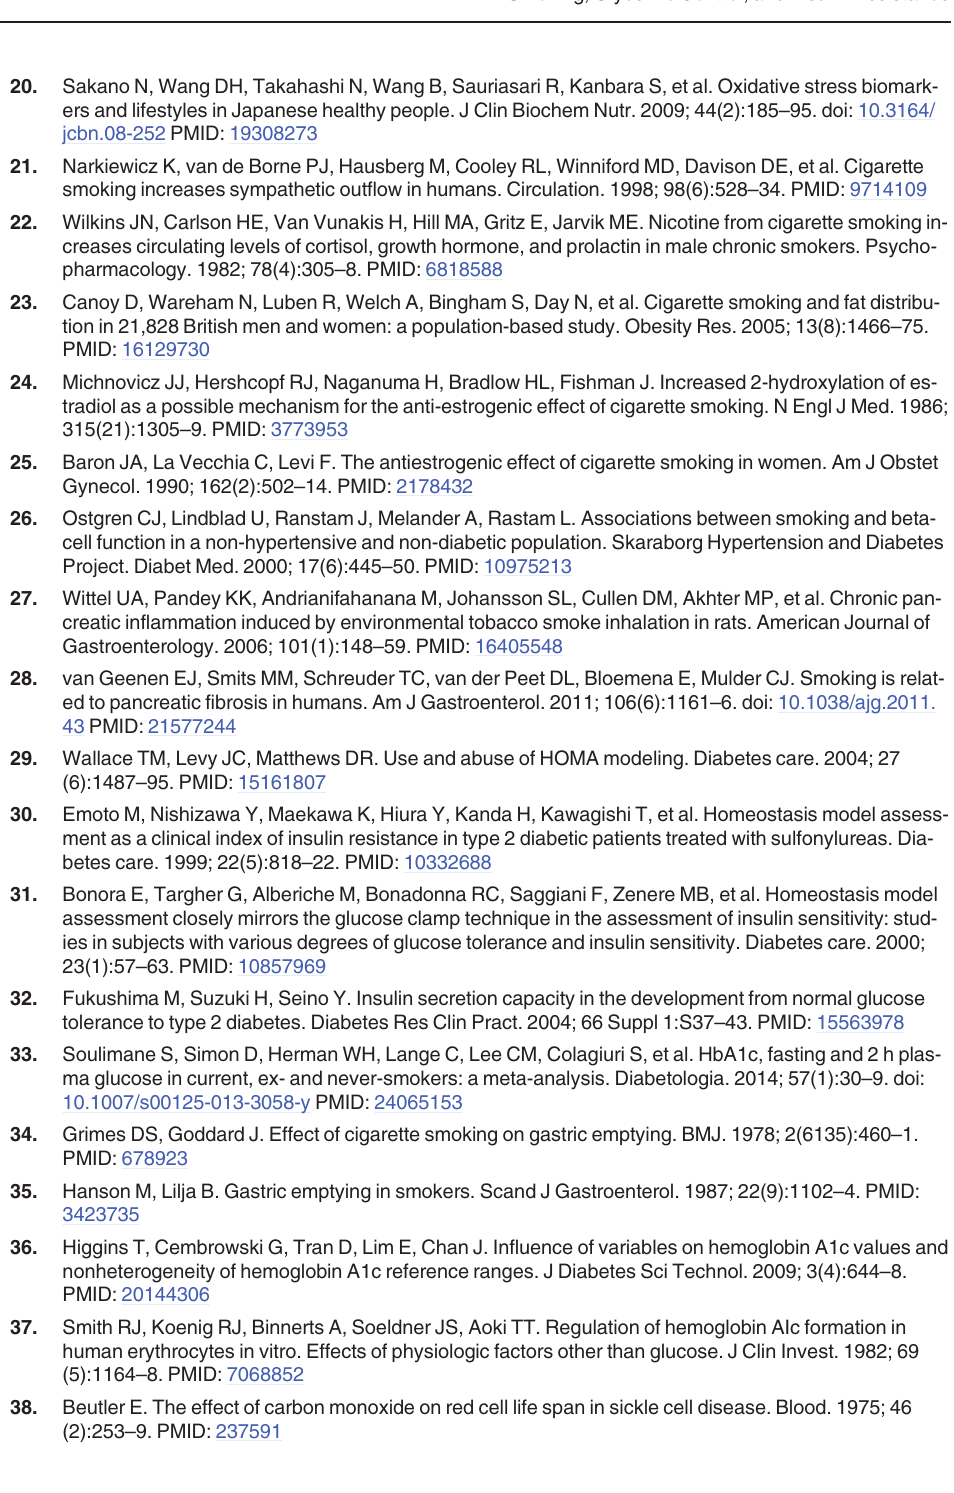
PLOS ONE | DOI:10.1371/journal.pone.0122023 March 30,